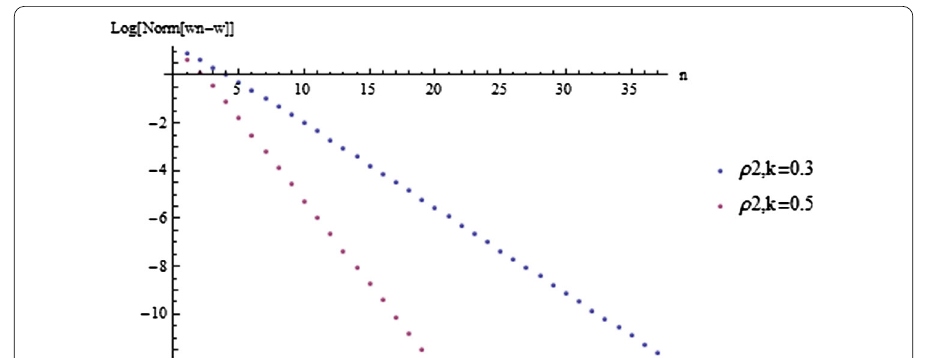
Figure 1 Error = 10 –5 , w 1 = (6,10,2), w = (8,8,0)